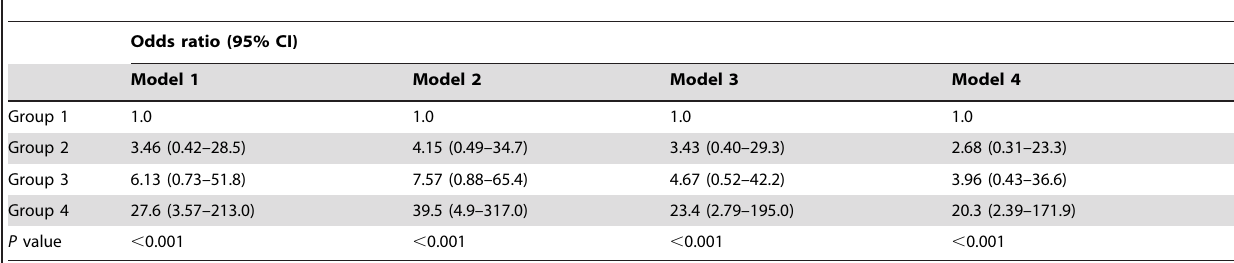
Table 6. Relationship between daily dosage of sulfonylurea regimen and vitamin B 12